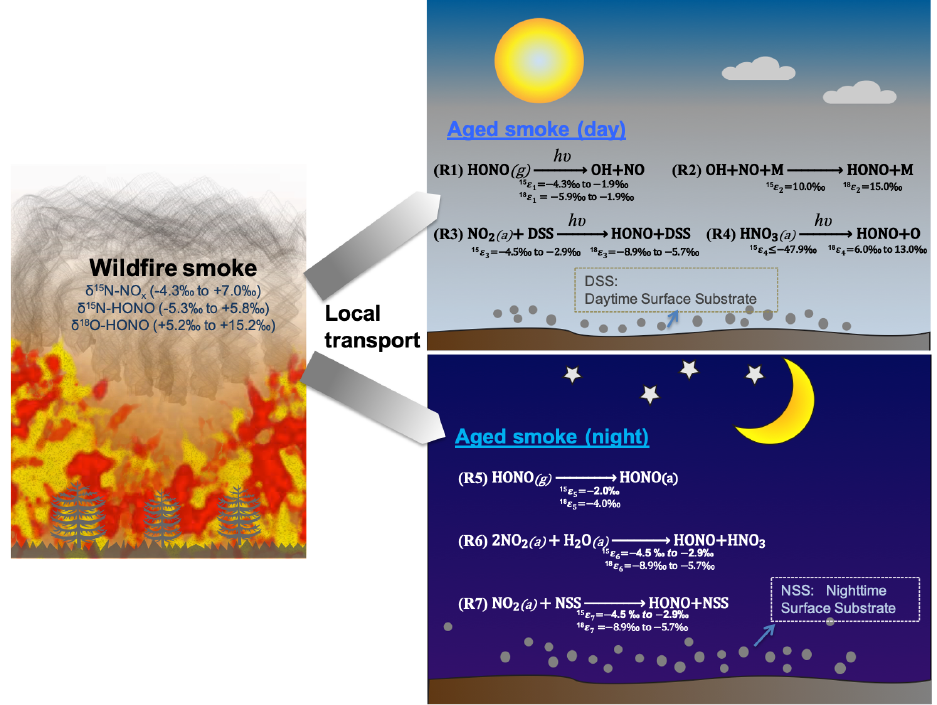
Figure 1. The schematics of loss and secondary production of HONO in areas impacted by wildfire smoke in daytime (Reactions R1–R4) and nighttime (Reactions R5–R7). We conducted our sample collection < 30km from the edge of the wildfires, with smoke ages ranging from a few minutes to half a day. M is bath gas including N 2 , O 2 , CO 2 , etc. DSS is daytime substrate surface including terrestrial surfaces and aerosol particles that incorporate photoactive metal oxides (e.g., TiO 2 ), humic-like organics (e.g., quinone), etc. In essence, solar radiation induces reduction of these substrates with H, and this facilitates H abstraction by NO 2 (or H transfer). NSS is nighttime substrate surface (terrestrial and aerosol surfaces) containing iron-bearing minerals and/or humic acid (quinone). Note other sinks during both day and night (e.g., OH + HONO) are negligible compared to the major sinks shown here. Isotopic enrichment factors for N and O result from kinetic isotopic effects associated with each reaction and are calculated and expressed as 15 ε i and 18 ε i , where the subscript i indicates the reaction number, and the superscripts 15 and 18 denote the isotopic composition 15 N/ 14 N and 18 O/ 16 O,